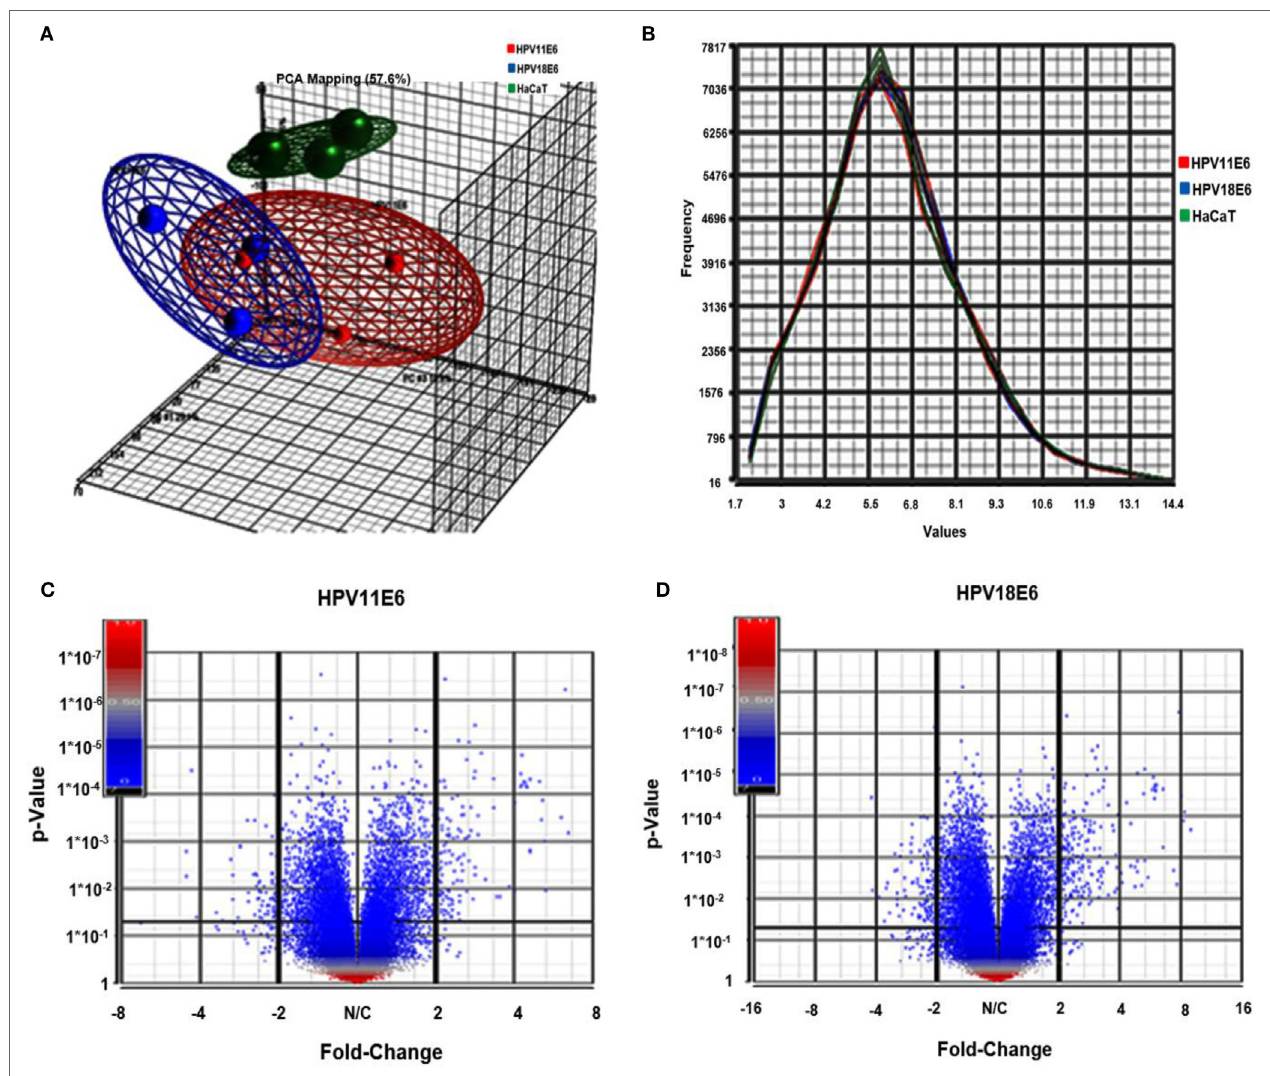
FigUre 3 | Analysis of microarray data in the infected HaCaT cells. (a) Principal component analysis (PCA) analysis plots (showing one dot for each of the triplicate samples) for the HaCaT control cells (green), the HPV11E6 (red), and the HPV18E6 (blue) cells. The HPV11E6 and the HPV18E6 cells had some similarity to each other and both were distinctly different from the control cell. (B) Line graph plots with one line for each of the samples with the intensity of the probes indicated on the X -axis and the frequency of the probe intensity on the Y -axis. In this dataset, all the samples follow the same distribution pattern indicating that there are no obvious outliers in the data. (c,D) Volcano plots of HaCaT cells expressing HPVE6 vs. HaCaT control cells with each dot representing a gene. The X -axis shows the fold change and the Y -axis the p -values. The up- and downregulated genes are on the right- and left-hand side,